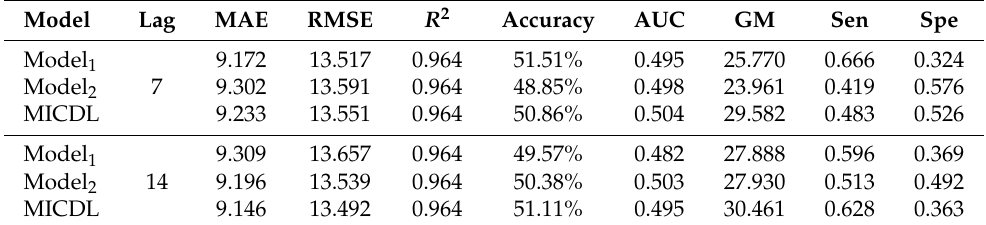
Table 5. Performance of the evaluated models for all ETH data.